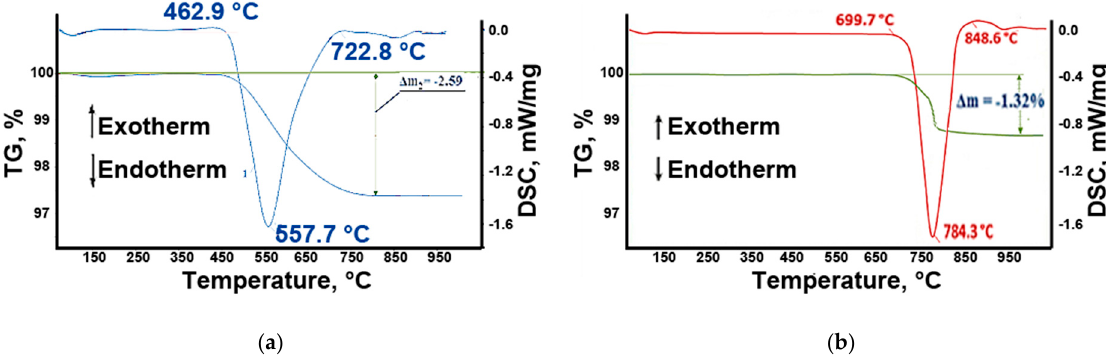
Figure 14. Dependence of TG and DSC on the temperature of unmodified ( a ) and modified ( b ) spherical granules of titanium hydride.